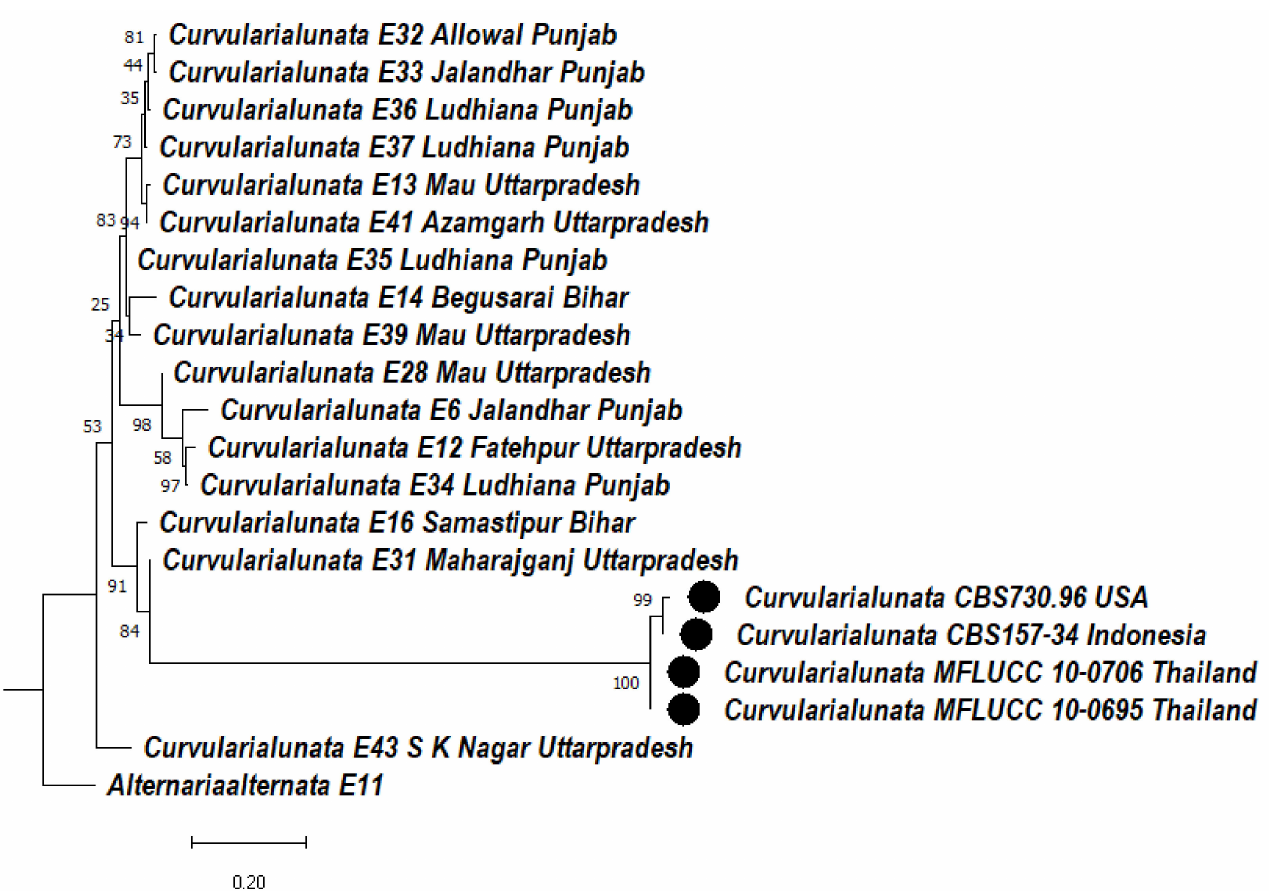
Figure 6. Dendrogram constructed from maximum likelihood method based on combined internal transcribed spacer (ITS) and glyceraldehyde-3-phosphate dehydrogenase (GAPDH). Sequenced data of the Curvularia lunata isolates were inferred with Raxml based on GTR + Gamma model. Numerical value presented in the node indicates bootstrap value with a 1000 non-parametric bootstrap replicate analysis. The symbol • denotes as ‘ ex-type ’ closely related species sequences obtained from